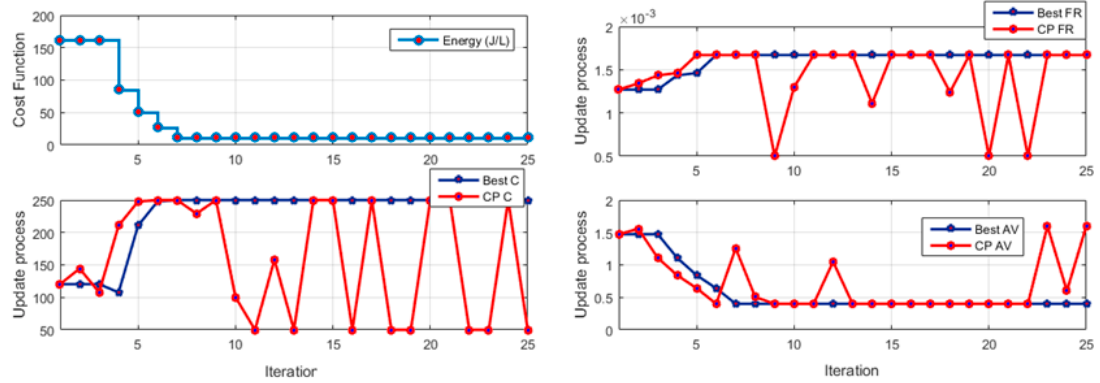
Figure 4. The cost function variation, best values of decision variables during the optimization process of energy consumption per liter. C is the capacitance, CP is the center point, FR is the flow rate, SV is the spacer volume, AV is the applied voltage, and CV is the cell